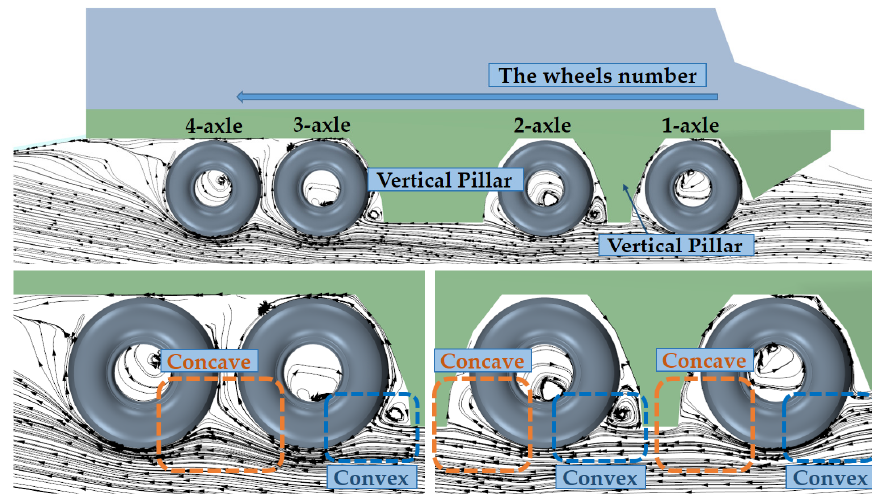
Figure 13. The streamline of the TS model in the wheel longitudinal section at Fr = 0.624.